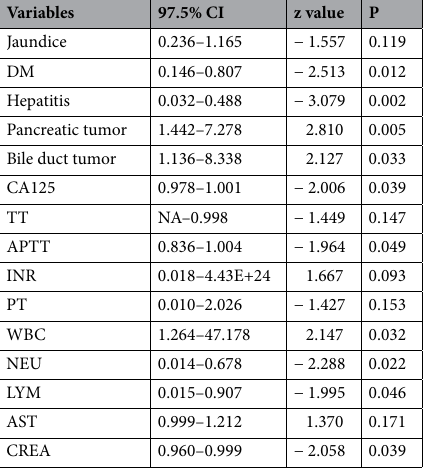
Table 2. Statistical characteristics of the stepwise (stepAIC) selected model for postoperative hemorrhage. DM diabetes mellitus.